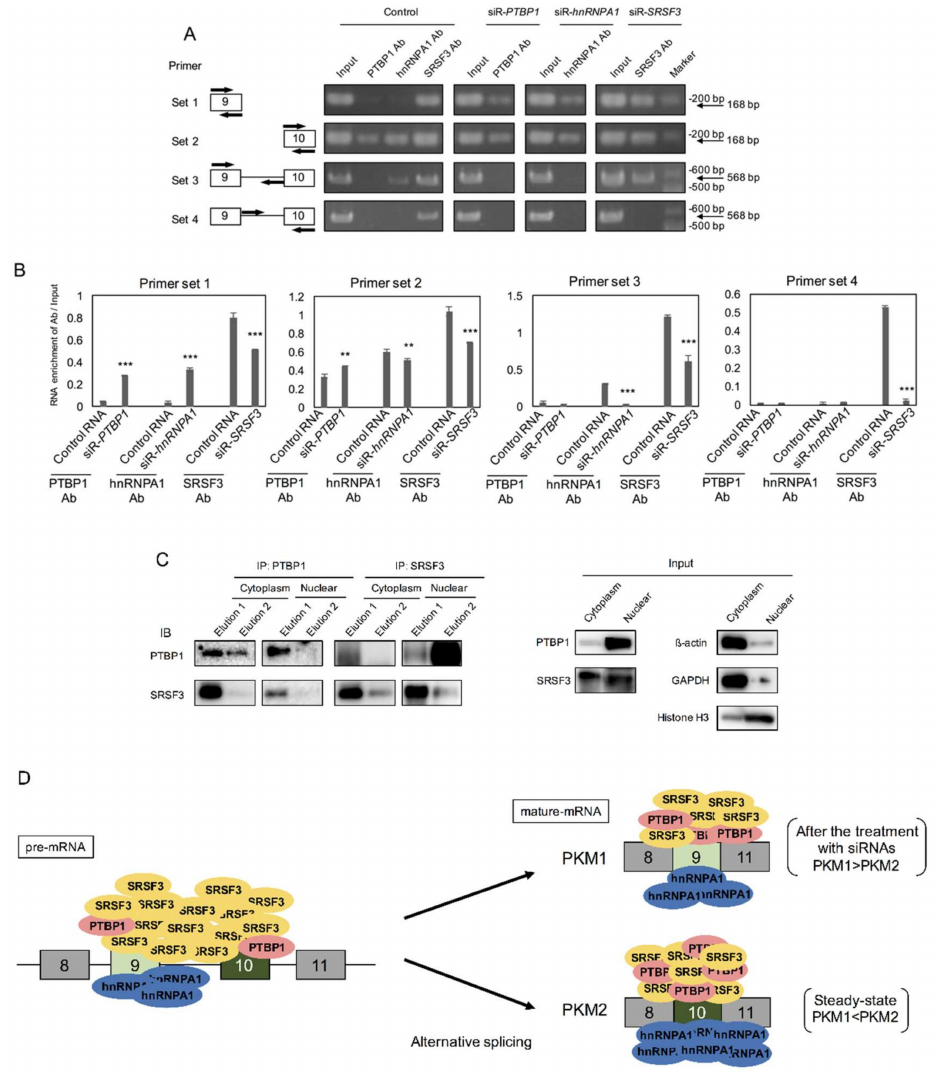
Figure 6. Molecular relationship among SRSF3, PTBP1, and PKM mRNA. ( A )Amounts of PCR-fragments from PKM1 and PKM2 mRNAs obtained by RIP assay. The samples are from the cells treated with each siRNA. The detail is shown in the Materials and Methods section; ( B ) Densitometric values of the bands of (A); ( C ) Western blot of PTBP1 and SRSF3 proteins from immunoprecipitation assay samples; ( D ) Scheme of relationship between splicing factors, PTBP1, hnRNPA1, and SRSF3, and PKM mRNA. ** p < 0.01; *** p < 0.001 (Student’s t